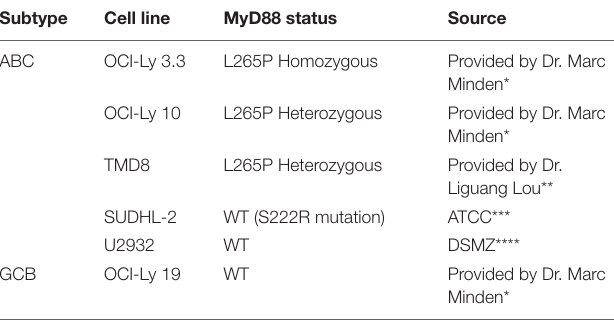
TABLE 2 | Characteristics of cells used in the